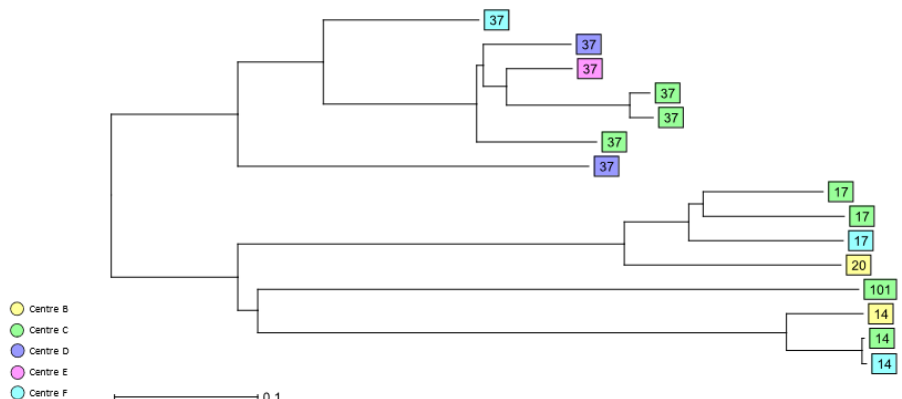
Figure 4. Dendrogram generated using Ridom SeqSphere+ for the HiR 3GCS/CS K. pneumoniae complex bloodstream isolates ( n = 15) coloured by study centre and identified by ST type, ignoring missing values. Each box represents one isolate from an individual patient according to sequence analysis of 2358 cgMLST target genes. Table 3. Overview of acquired beta-lactamases of colonising and bloodstream K. pneumoniae complex isolates.